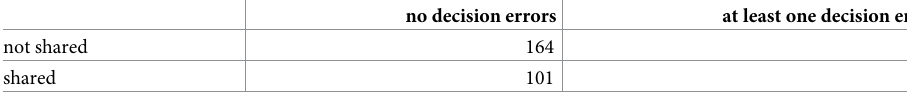
Table 7. Data sharing and presence of decision errors per paper.